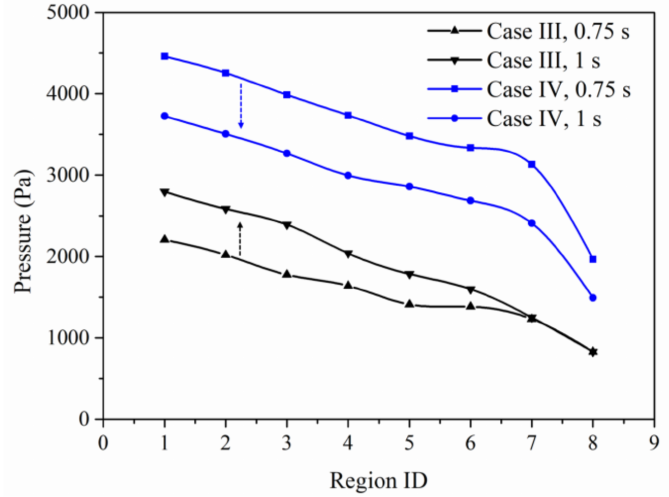
Figure 12. Average pressure distribution along the flow direction in case III (alternate injection) and case IV (alternate